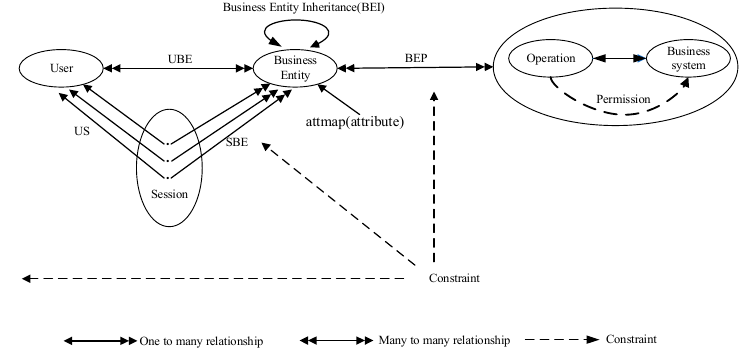
Figure 3. Access-control model diagram, based on business entity.